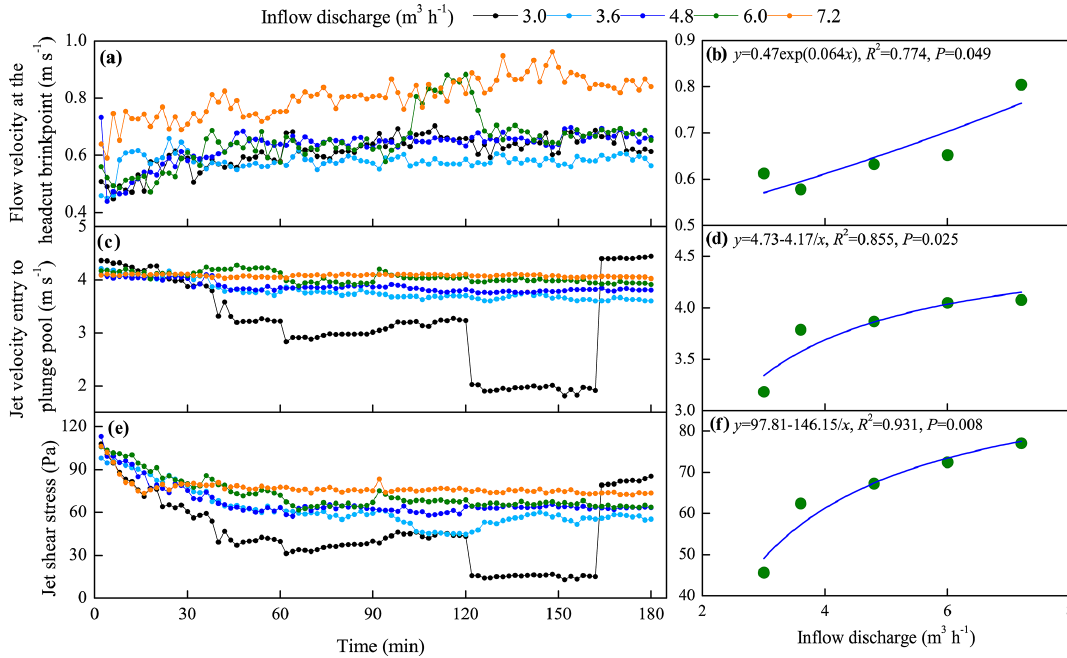
Figure 4. Temporal changes in jet properties of headcut and their relationships with inflow discharge. Table 1. The relationships between jet properties of gully headcut and